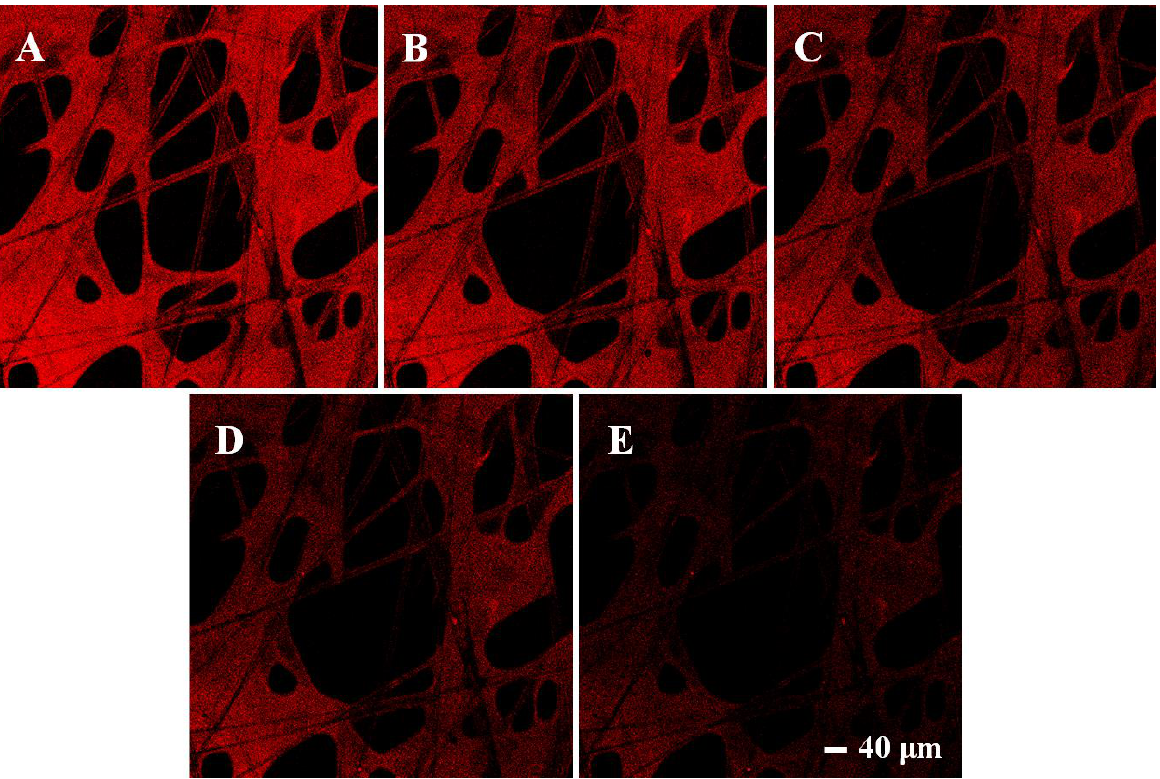
Figure 9. Fluorescence confocal microscope images of CdSe QDs in the imprinted paper chip when dimethoate was added at 0 ( A ), 10 ( B ), 20 ( C ), 40 ( D ), 80 μM ( E ), respectively.